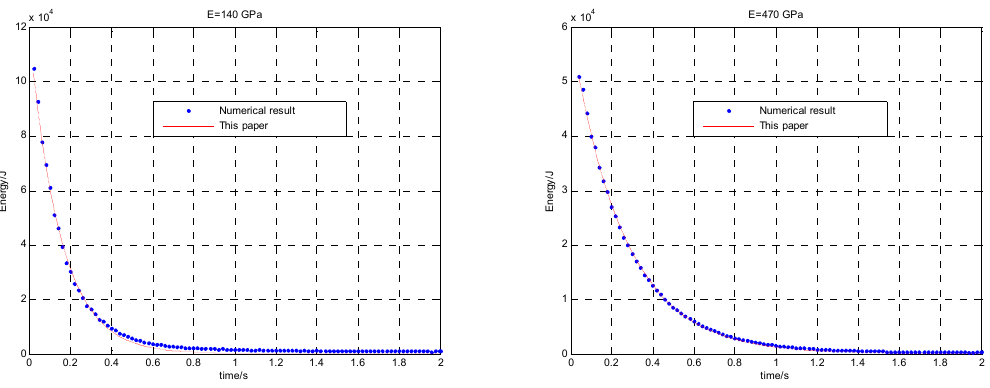
Figure 31. The plot and fitting curve of energy vs. time with E = 140 and 470 in case 1, respectively.